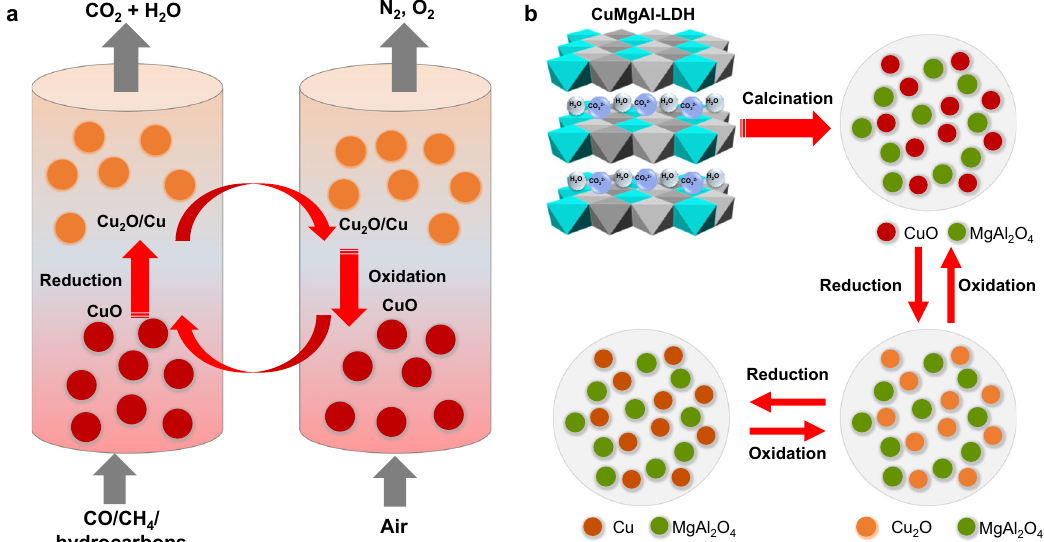
Fig. 1 | Schematic illustration of thermochemical looping process and design strategyofoxygenstoragematerials.a Schematicdiagramshowingthechemical looping redox cycle process in which copper oxides undergo cyclic reduction and oxidation reactions. The thermochemical redox reactions lead to a separate purestreamof CO 2 after water is removed, whichcan be utilized or stored